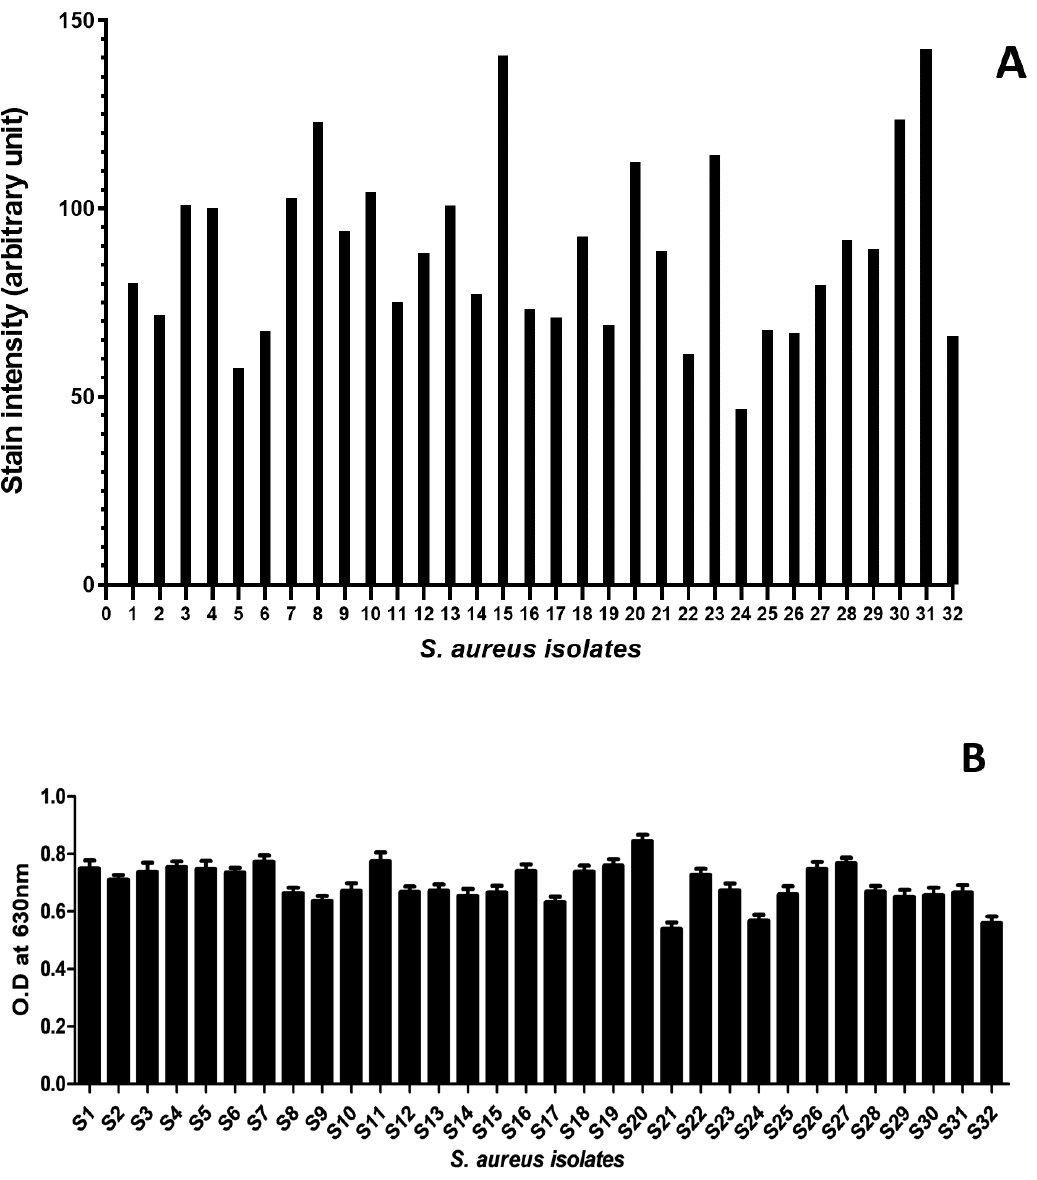
Figure 1. Qualitative and quantitative analysis of biofilm formation by S. aureus isolates: ( A ) biofilm staining intensity, for each isolate, measured using ImageJ software. The plot shows mean staining intensity (arbitrary unit) at the Y -axis, while the X -axis shows the isolates tested (S1–S32). ( B ) spectrophotometric analysis (OD630 nm) for the biofilm formation for each isolate. The plot shows mean OD values with standard deviation as an error bar on Y -axis, while isolates on X